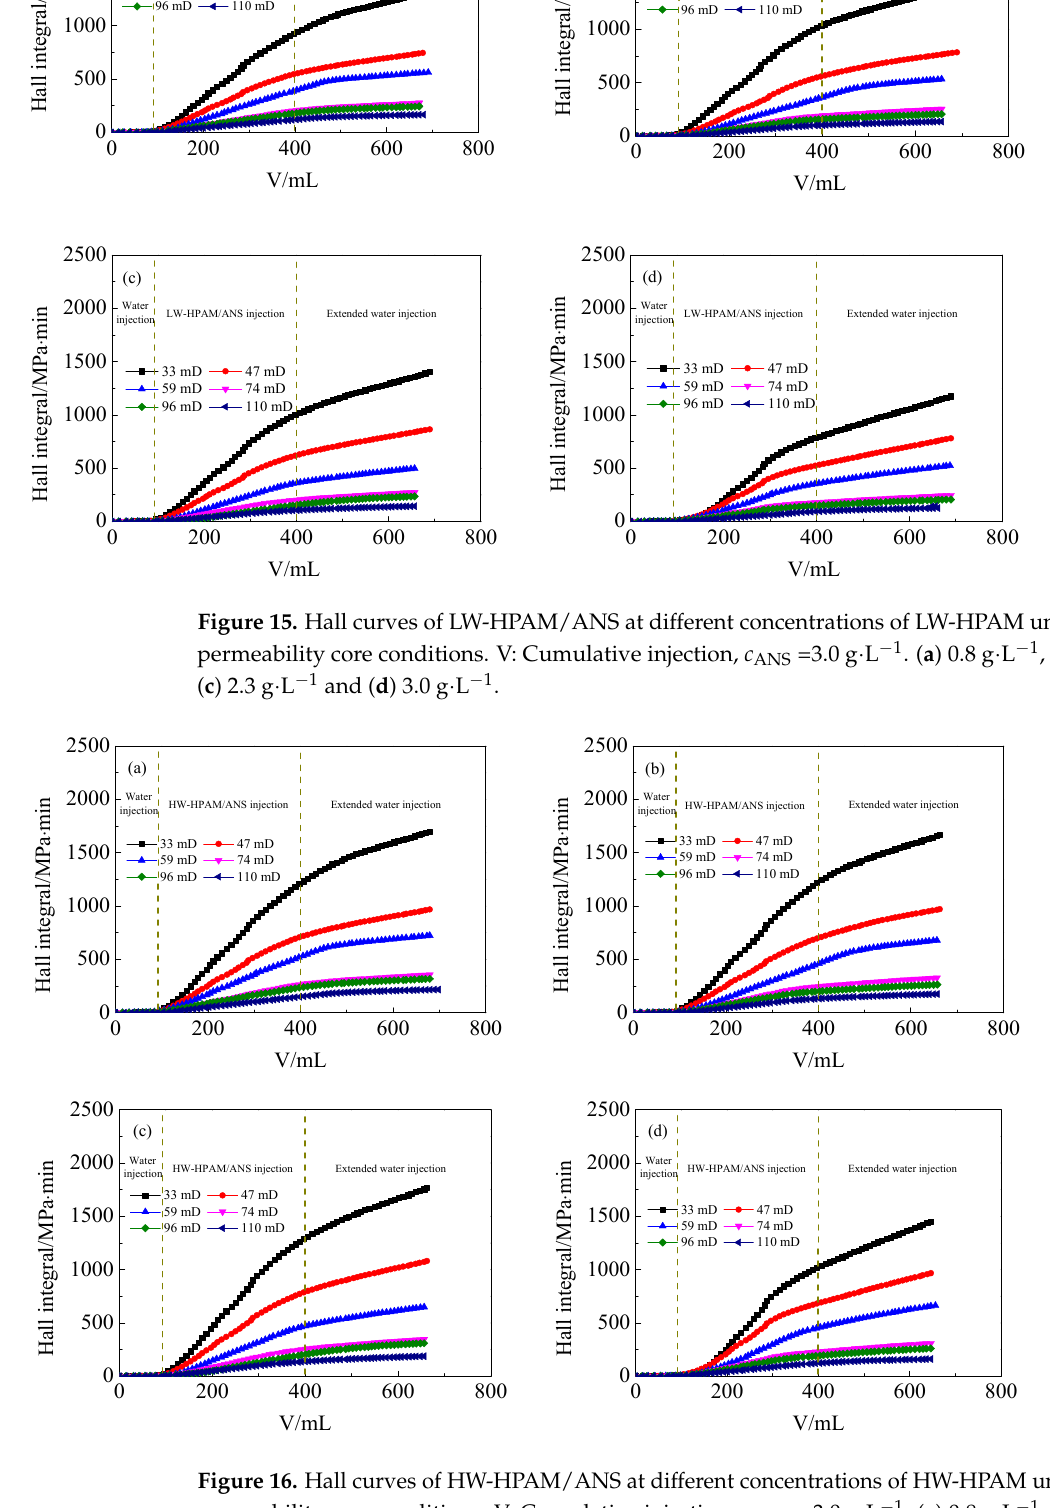
Figure 16. Hall curves of HW-HPAM/ANS at different concentrations of HW-HPAM under different permeability core conditions. V: Cumulative injection, c ANS = 3.0 g ⋅ L − 1 . ( a ) 0.8 g ⋅ L − 1 , ( b ) 1.5 g ⋅ L − 1 , ( c ) 2.3 g ⋅ L − 1 and ( d ) 3.0 g ⋅ L − 1 .